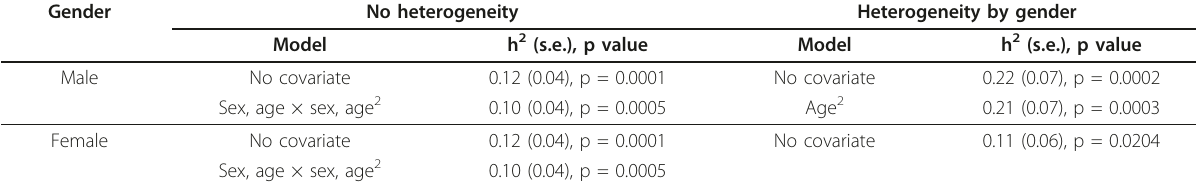
Table 5 Heritability estimates for the daily PA phenotype from analysis with separate data sets by